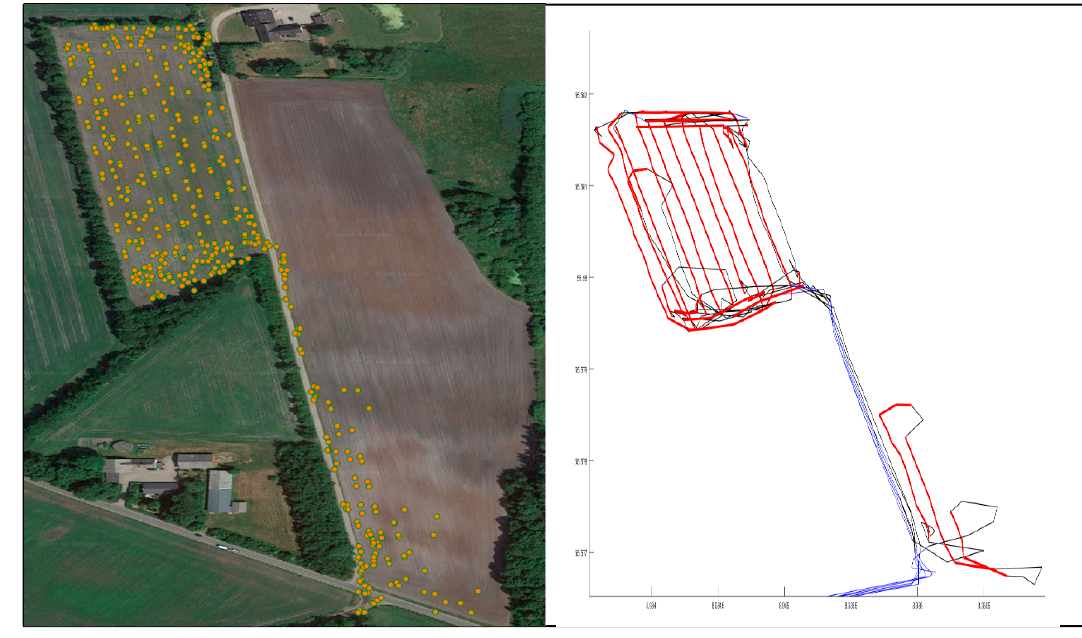
Figure 8. Conventional method.